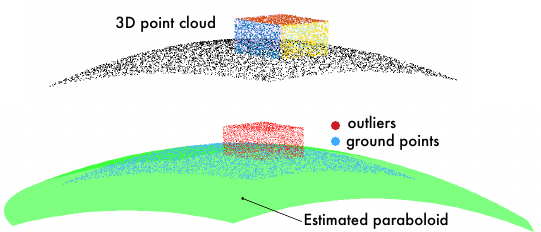
Figure 2. Ground detection with robust paraboloid fitting. A toy example with synthetic data TOP : the input data are given by the points on a paraboloid and points on a box lying on top of it (colored for visualization purpose). Gaussian noise is added on point coordinates BOTTOM : the paraboloid estimated via LMedS is displayed in green. Forward Search is used to dichotomize between inliers in light blue and outliers in red. necessary to instantiate a model (e.g. 3 points for instantiate a plane or 7 to fit a paraboloid) are randomly selected from the data, and a parameter vector a S is fitted to the points in each sub- set. Hence, each a S is tested by calculating the squared residual distance r 2 i, a of each of the n − k points in X − S and the me- S dian of the residuals is computed. The a S corresponding to the smallest median is chosen as the estimate ˆ a . If n is the number (cid:1) different of points in the initial set of data, there are (cid:0) n k